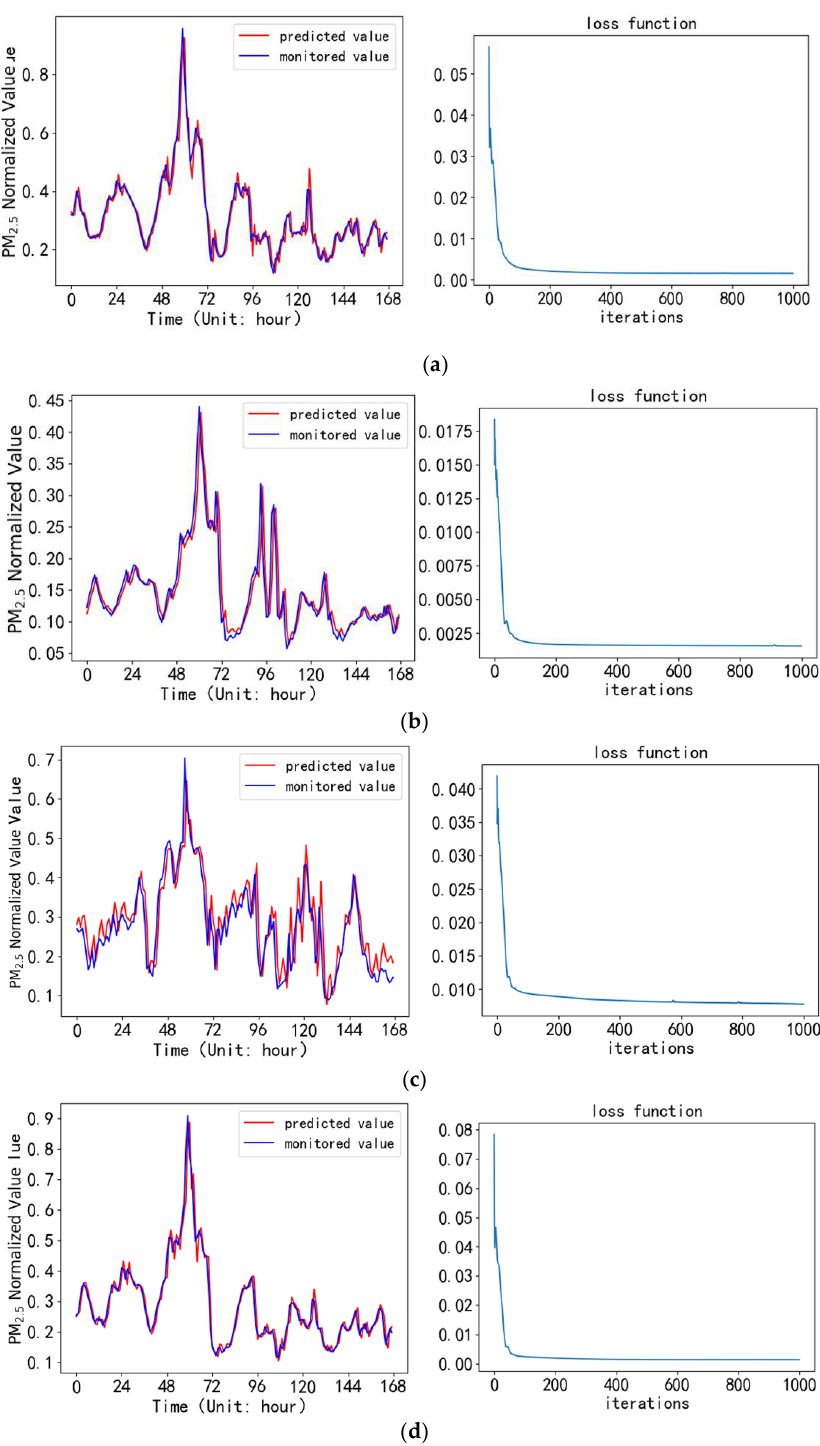
Figure 5. Comparison between predicted values and monitored values by GRU model in the coming week, and the figures of loss function: ( a ) High-tech Zone Site; ( b ) Shangcheng Community Site; ( c ) Luhe Countryside Site; ( d ) NJAU-Pukou Campus Site.